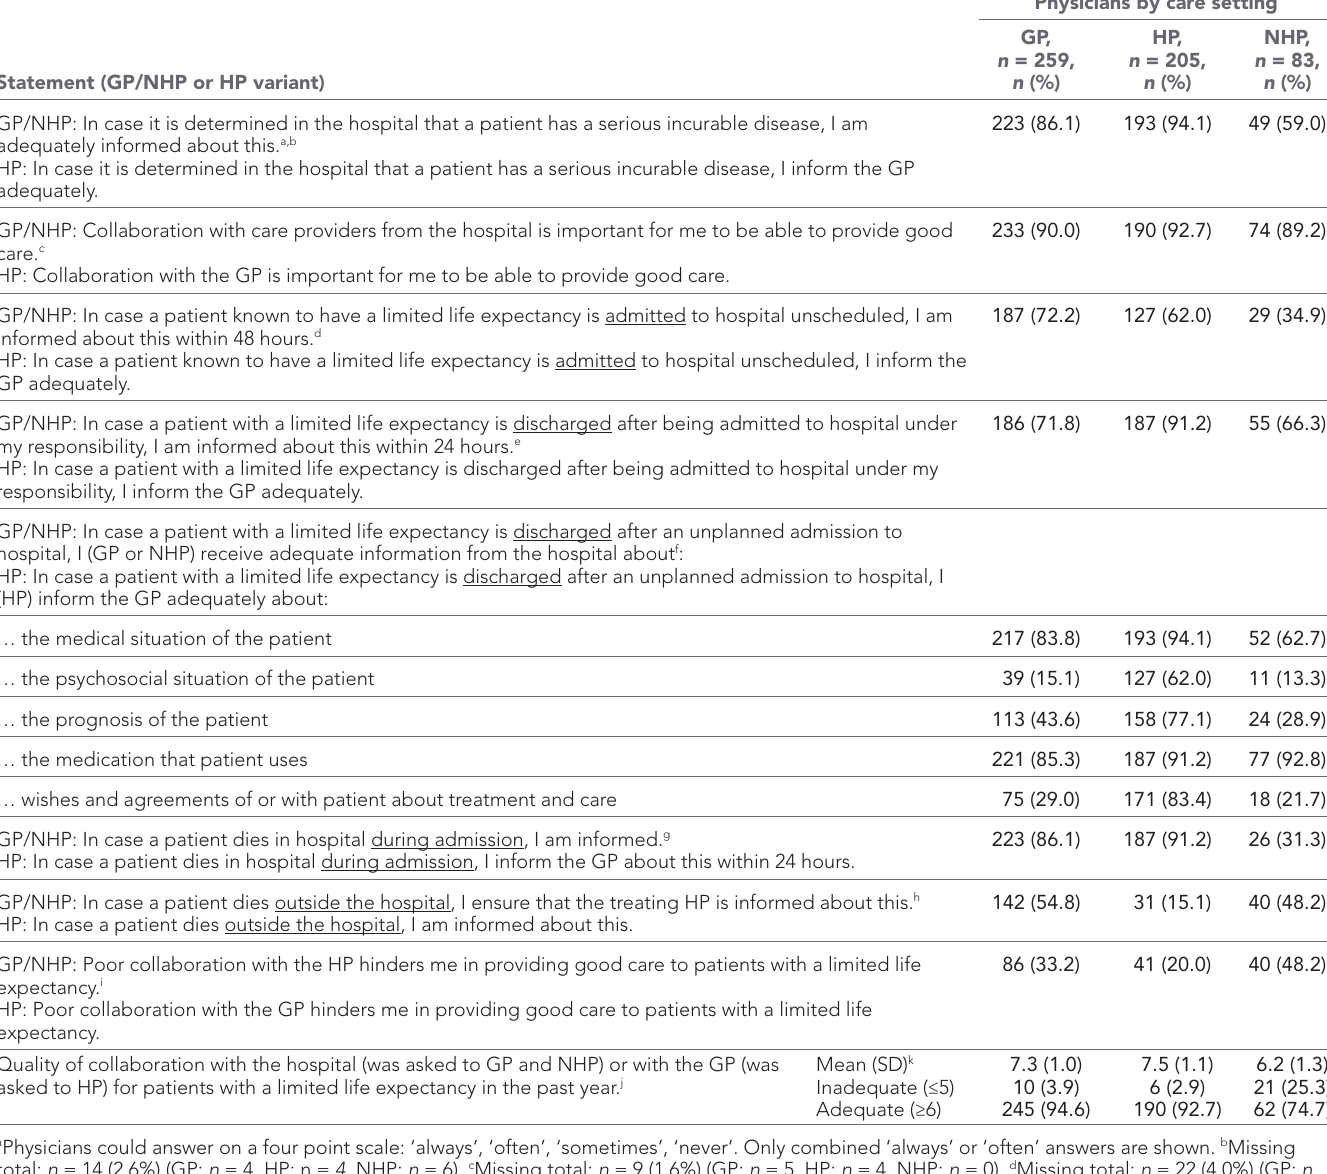
Physicians by care setting GP, n =